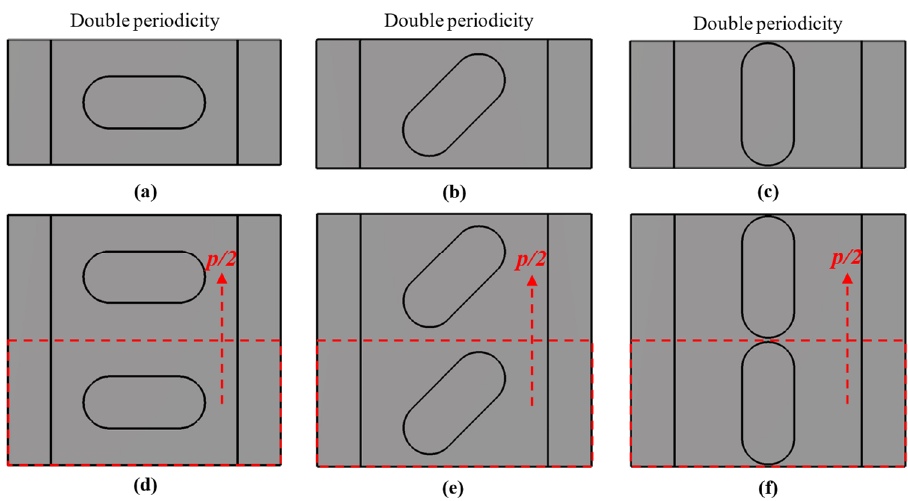
Figure 2. Double periodic configuration for different angles θ 1 = − θ 2 = θ . ( a , d ) θ = 0 ◦ ( b , e ) θ = 45 ◦ and ( c , f ) θ = 90 ◦ . ( a – c ) Base unit cells of the ( d – f ) double periodic unit cells.